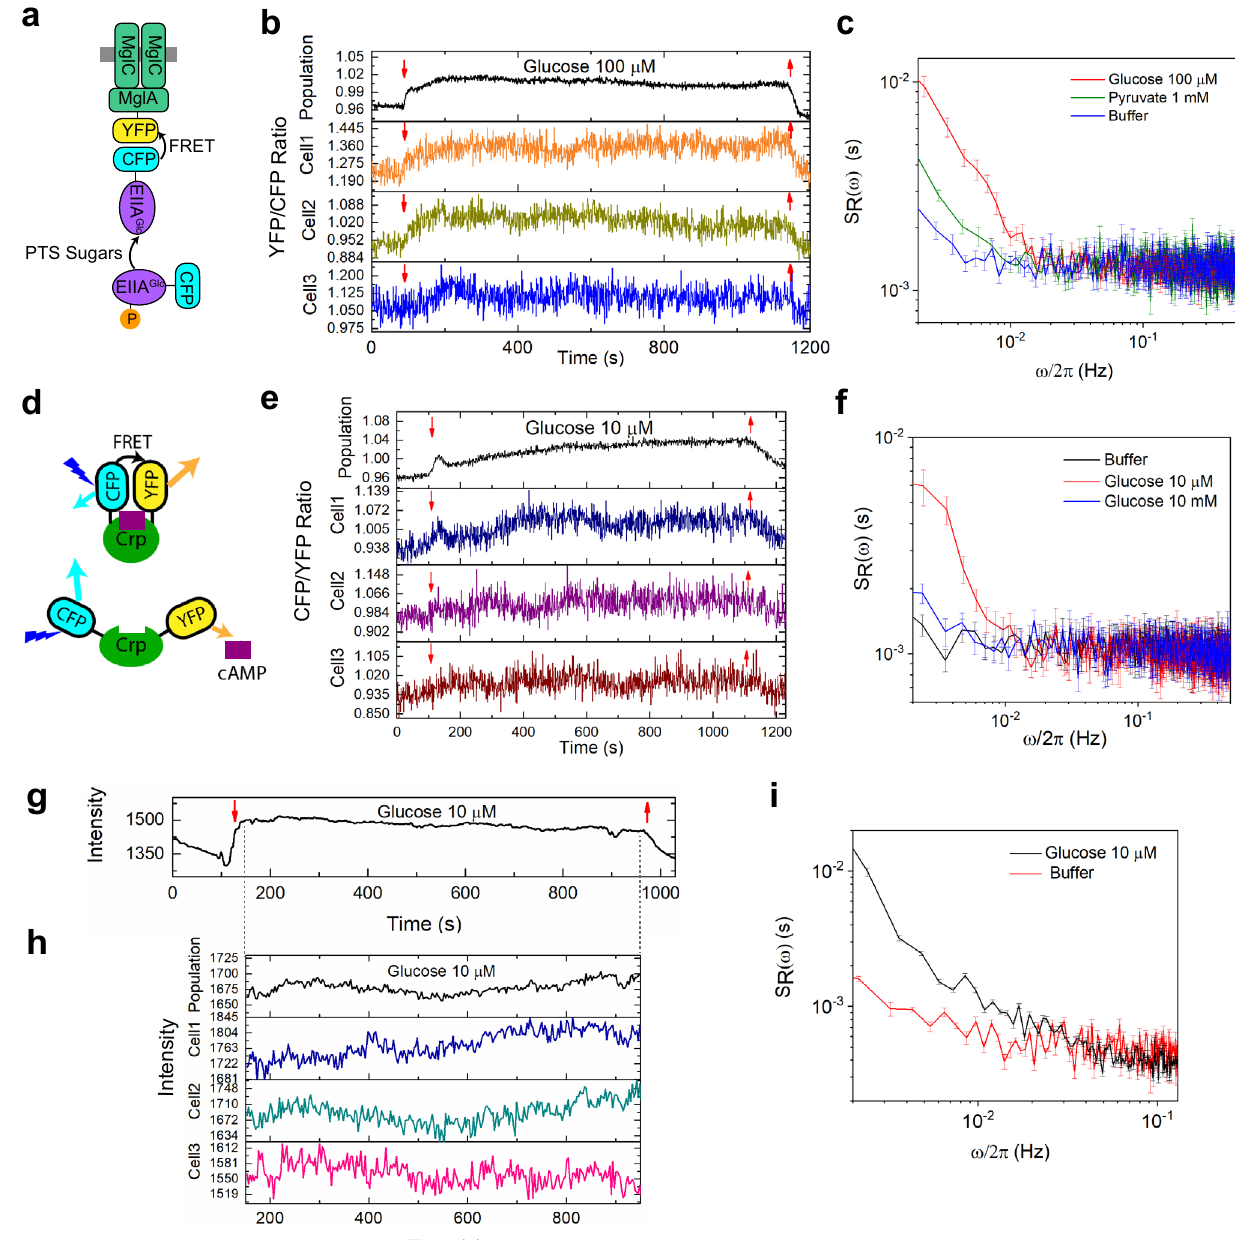
Fig.5|FluctuationsofthePTSactivityandtheintracellularcAMPandNAD(P)H levelin E.coli cellsexposedto glucose.a Schematicrepresentation of the EIIA Glc - CFP/MglA-YFP FRET pair used in this study as the readout of the PTS activity. Glucose transport leads to enhanced interaction of EIIA Glc with MglA, which increases resonance energy transfer from excited CFP to YFP and therefore increases the ratio of YFP to CFP fl uorescence. b Time course of population- averaged(black)andtypicalsingle-cell(colors)measurementsoftheFRETratiofor E. coli MG1655 cells expressing the EIIA Glc -CFP/MglA-YFP pair. Cells were fi rst equilibrated in buffer and subsequently stimulated by addition and subsequent removalof 100 μ M glucose, asindicated bydown and up arrows. c Corresponding average PSD of the FRET ratio fl uctuations for the EIIA Glc -CFP/MglA-YFP pair in presenceofglucose, pyruvate or buffer, as indicated.Cellsweregrown intryptone broth (TB). The sample sizes are 170 (glucose, 100 μ M), 93 (pyruvate) and 72 (buffer) single cells. d Schematic representation of the Crp-based cAMP sensor